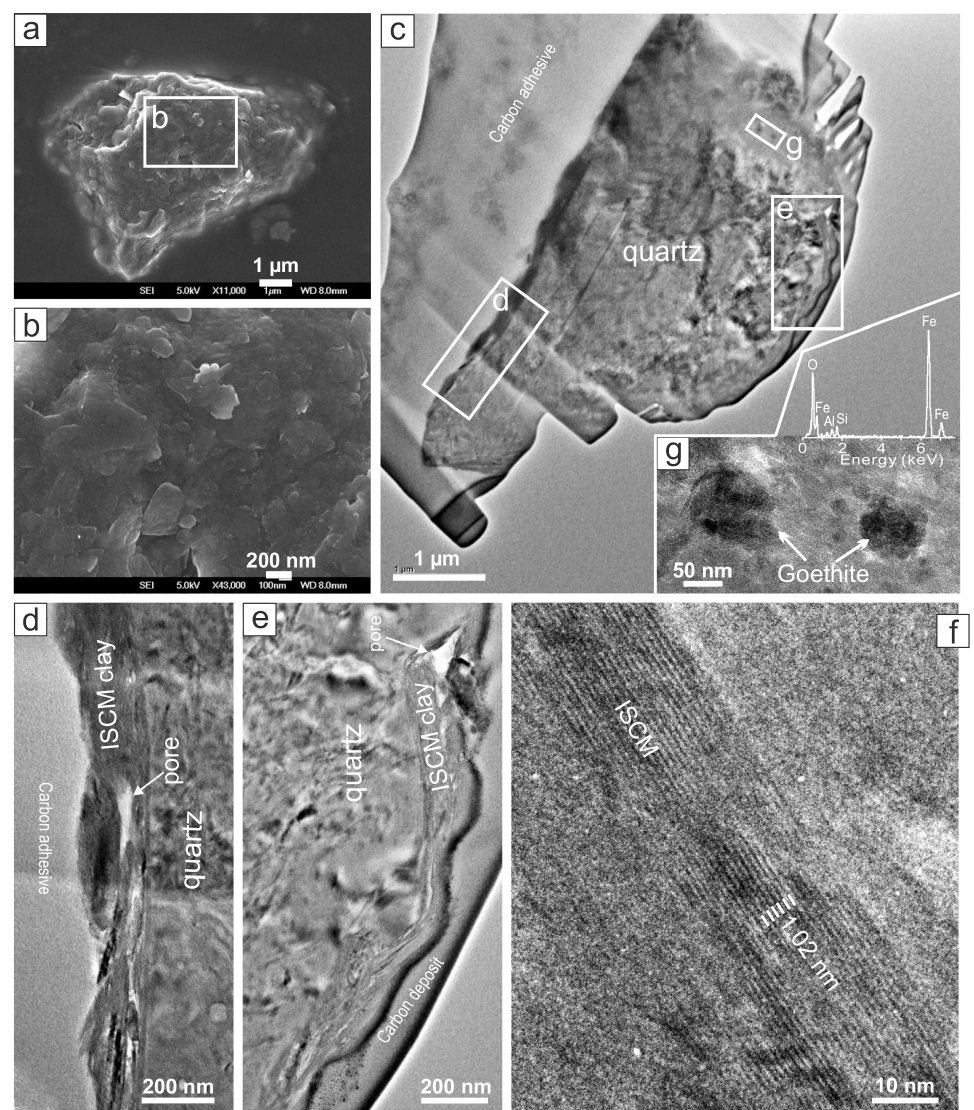
Figure 5. Quartz-rich dust particle #1 from 2009 Asian dust. (a) SEM image of the dust particle. (b) SEM image of the particle surface magnified from the box in (a) . (c) Overall TEM image of the FIB slice prepared from the particle in (a) . (d, e) TEM images magnified from the box in (c) . (f) TEM lattice fringe image of ISCMs. (g) Goethite spheres magnified from the box in (c) with the EDXS pattern of